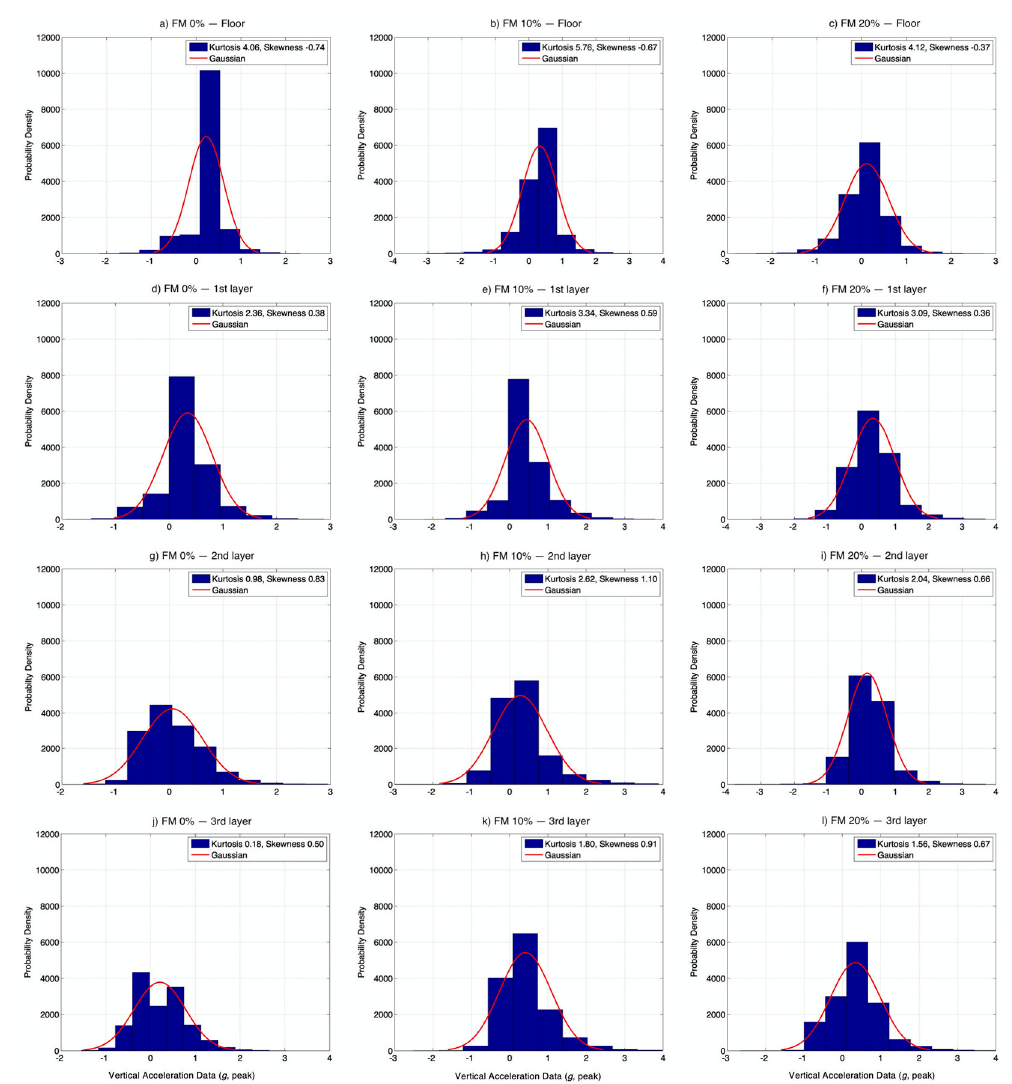
Figure 7. Transmissibility plots of the various layers in the vertical direction for ( a ) FM 0%, ( b ) FM 10%, and ( c ) FM 20%.